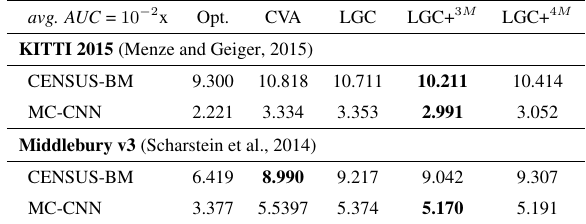
Table 3. Comparison of LGC (Tosi et al., 2018) and LGC+. For details on the AUC or on the table structure, please refer to Table